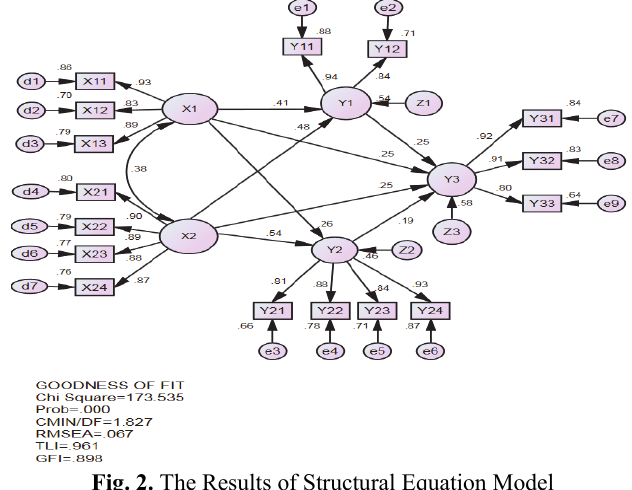
Fig. 2. The Results of Structural Equation Model